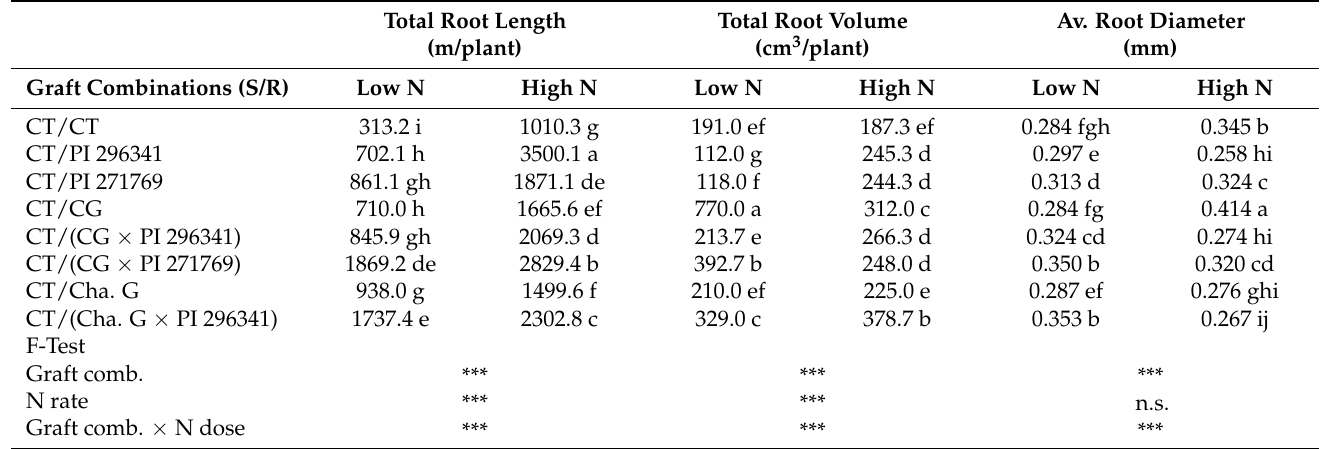
Table 4. Total root length, root volume and average root diameter of self-grafted and